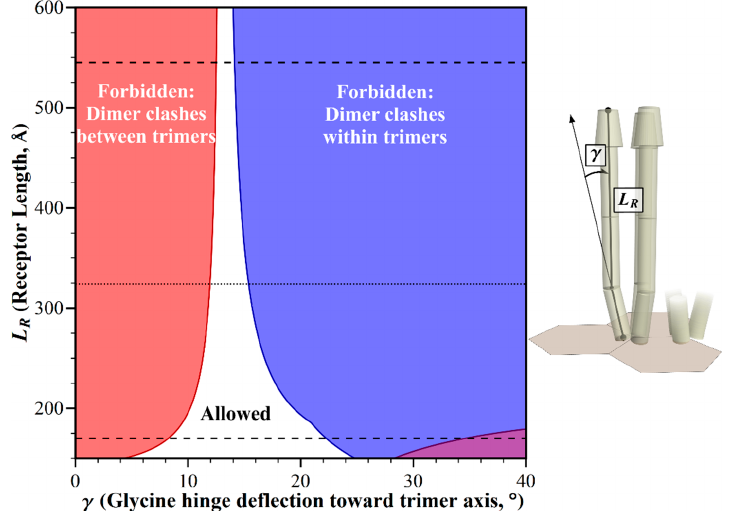
Figure 3. Geometric restrictions in core signaling complexes and their arrays as a function of chemoreceptor length, L R and glycine hinge deflection, γ . The plot shows the structural consequences of the combinations of receptor length and glycine hinge deflection. For allowed combinations (white area), receptors fit into the available space. For any forbidden combinations, they do not, because of structural clashes between dimers in neighboring trimers (red areas), or in the same trimer (blue areas). Estimated lengths of the longest and shortest receptors that could be assembled by combining the longest or shortest known receptor segments (see Materials and Methods), are marked by dashed lines. A dotted line marks the length of the E. coli